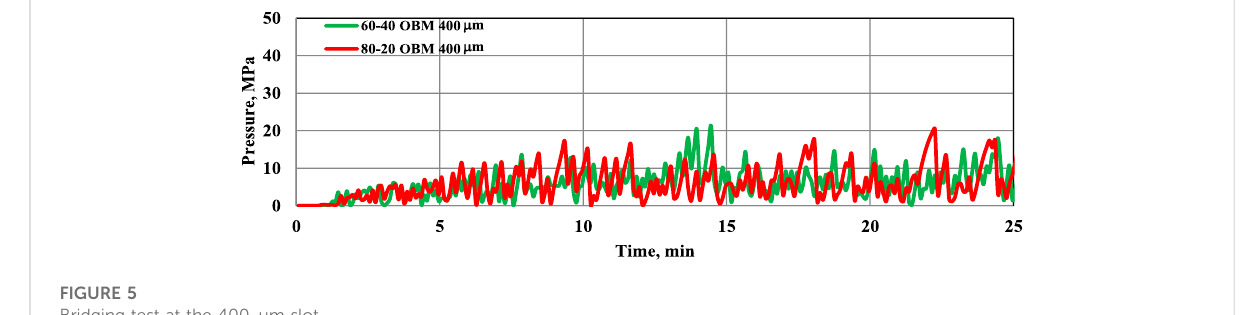
FIGURE 5 Bridging test at the 400- μ m slot.